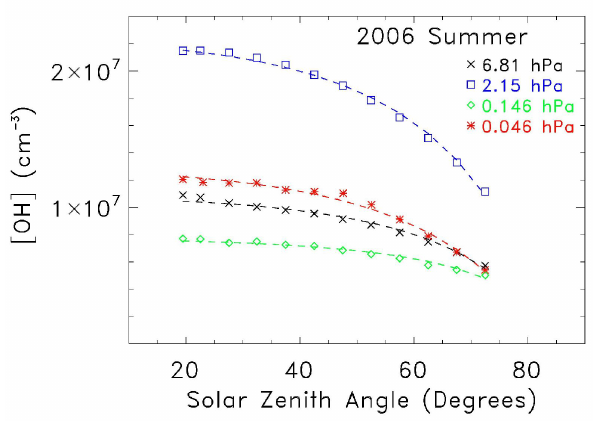
Fig. 3. Hydroxyl concentrations at 6.81hPa (black x’s), 2.15hPa (blue squares), 0.146hPa (green diamonds), and 0.046hPa (red *s) Figure 3: Hydroxyl concentrations at 6.81 hPa (black x's), 2.15 hPa (blue squares), obtained from full-day (morning+afternoon) averages within 5 ◦ solar zenith angle bins. Corresponding dashed curves show expo- 0.146 hPa (green diamonds), and 0.046 hPa (red *s) obtained from full-day nential function fits as described in the text. (morning+afternoon) averages within 5 o solar zenith angle bins. Corresponding dashed curves show exponential function fits as described in the text.